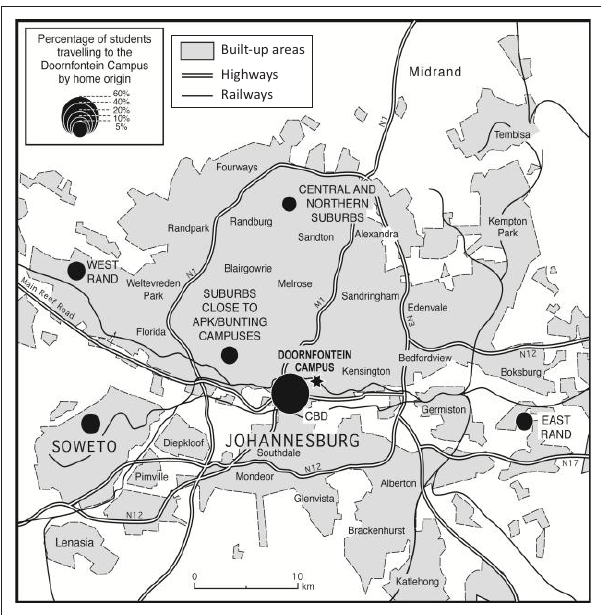
FIGURE 2: Origin of Doornfontein Campus students.